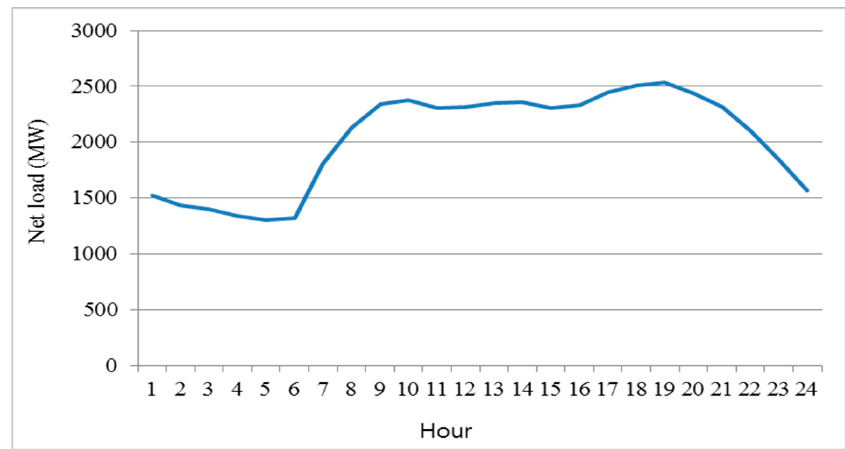
Figure 4. Forecasted net-load profile.